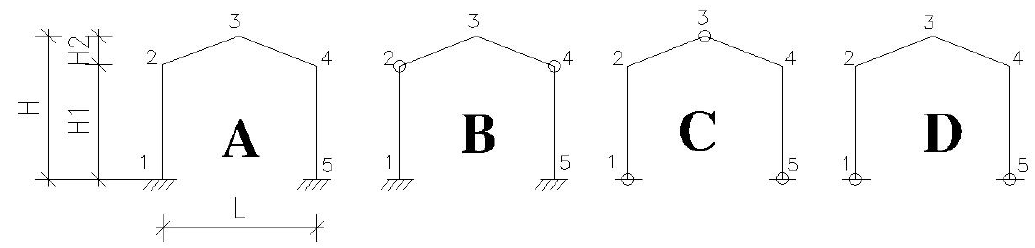
Figure 2. Research diagrams of steel halls.